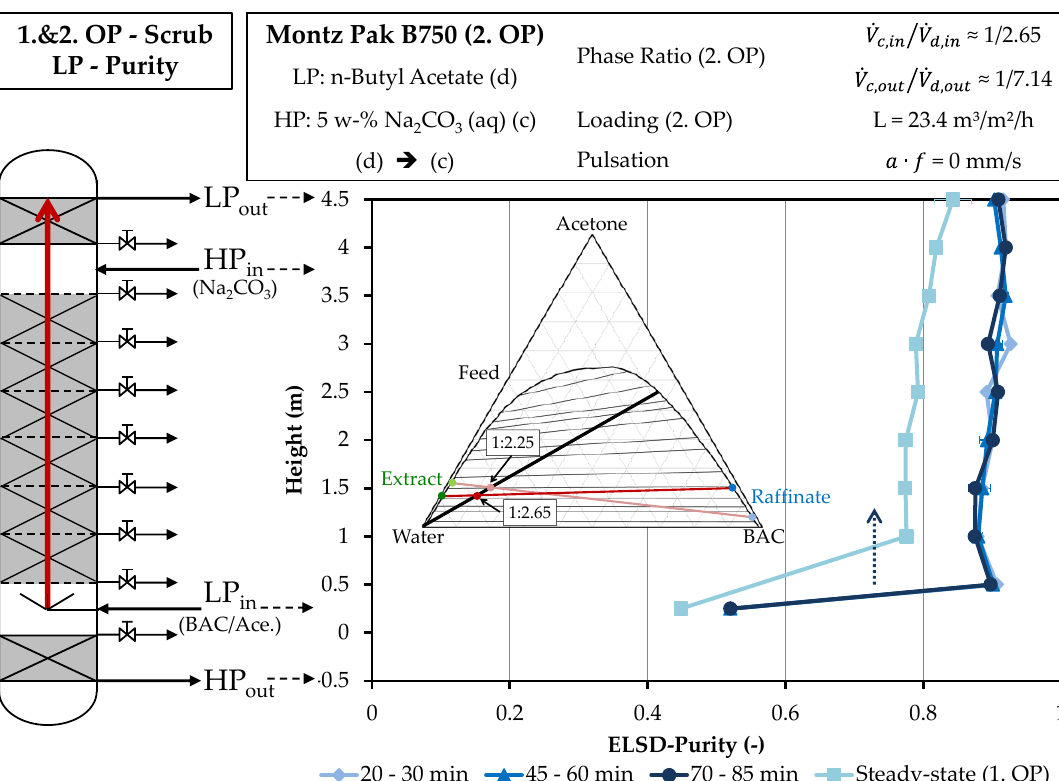
Figure 11. Comparison of the purity profiles across the column height of the light phase in the experimental progression of the first and second operating points of scrubbing. Purities are obtained by HPLC method described in Section 3.2.